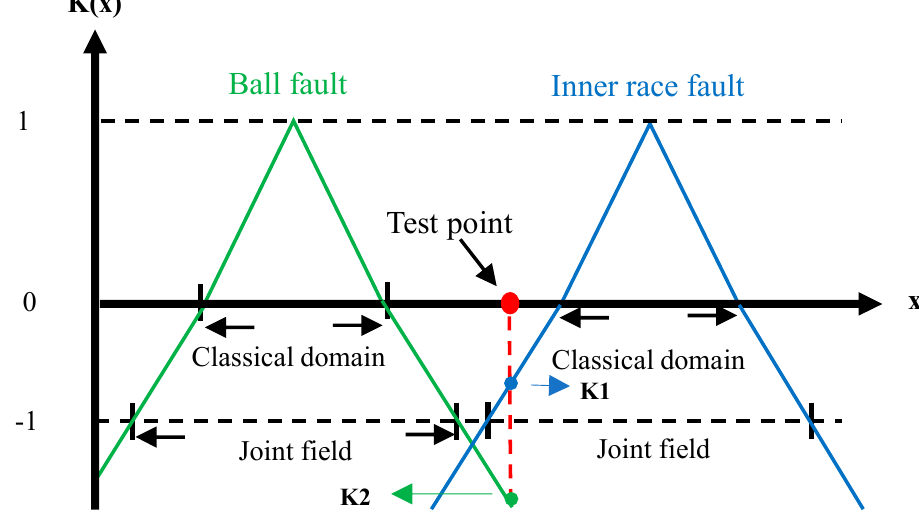
Figure 9. Illustration of a correlation function.